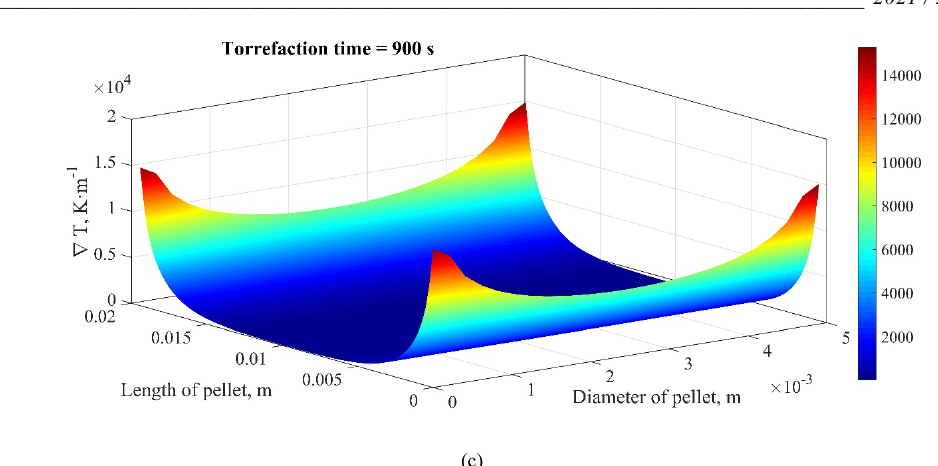
Fig. 6. Variation in the temperature gradient across the pellet: a) 81.55 kW·m − 2 ; b) 84.88 kW·m − 2 ; c) 86.068 kW·m − 2